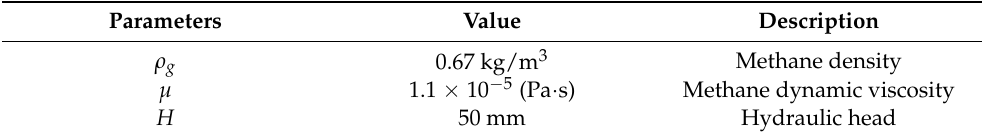
Table 2. Simulation model data.